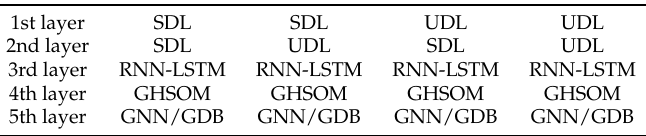
Table 1. Stack models for final